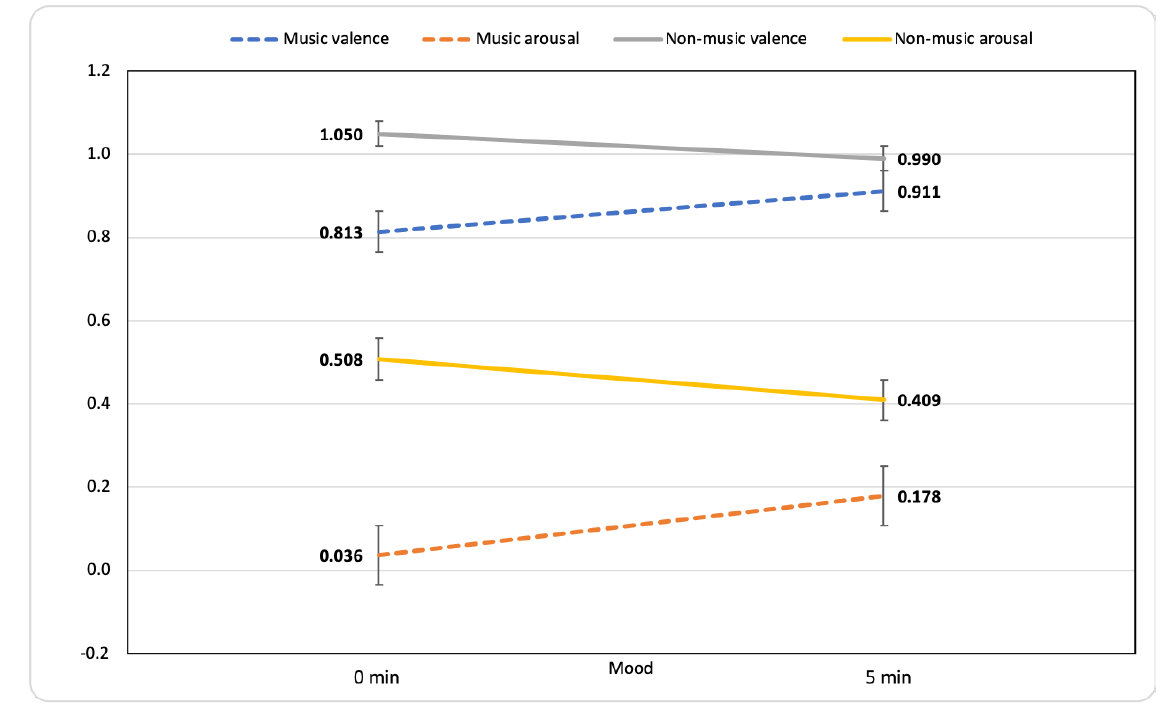
Figure 1. Mood changes across music and non-music episodes. Mean ratings (±SEM) for valence and arousal are illustrated at min 0 (first report) and min 5 (follow-up report). Dotted lines indicate a significant difference between ratings at min 0 and min 5. Valence and arousal answer scales ranged from − 3 (indicating a negative valence and a low arousal) to +3 (indicating a positive valence and a high arousal), see Section 2.4 Measures.